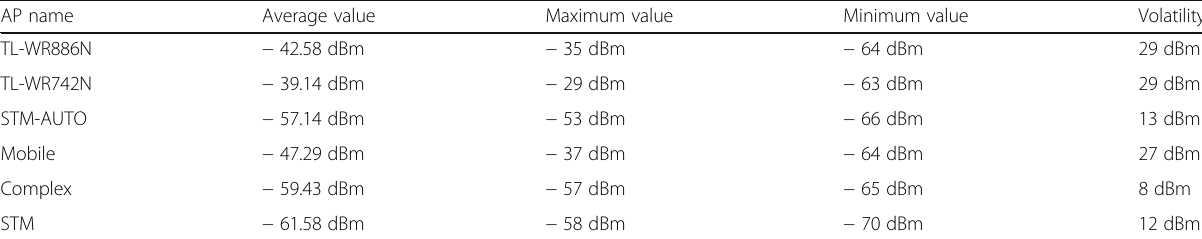
Table 1 Signal amplitude change table for different APs with fixed